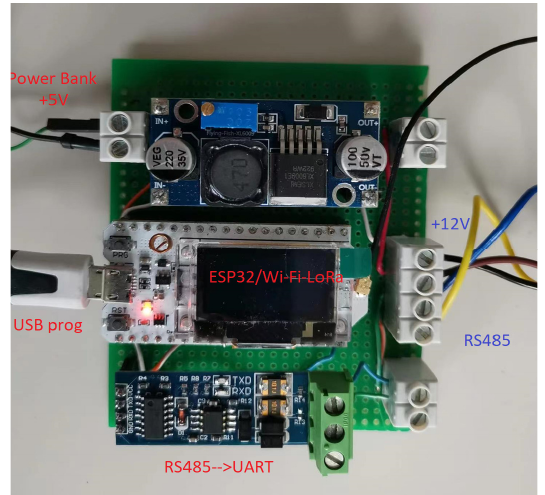
Figure 5. Smart sensor node implemented prototype.